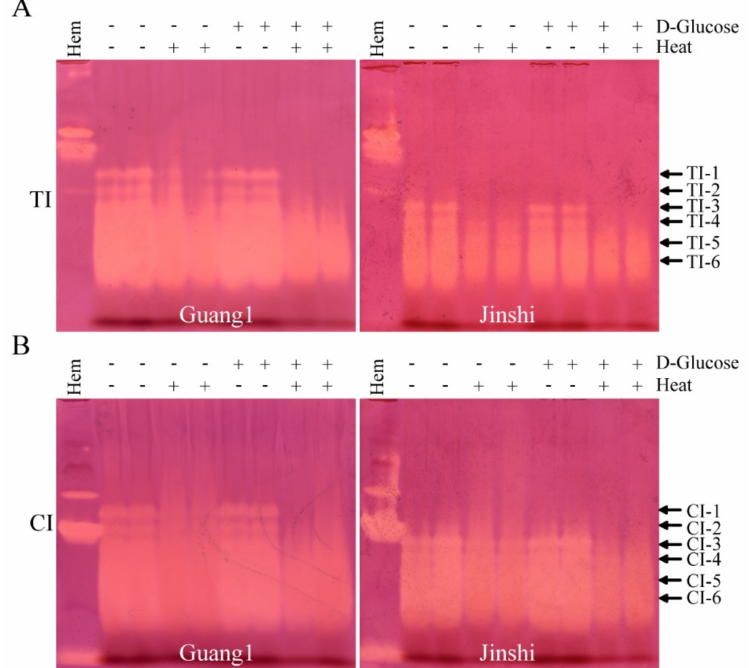
Figure 6. Maillard reaction could weaken the activities of TIs and CIs from leaves of Guang1 and Jinshi. Activity staining of TIs ( A ) and CIs ( B ) from leaves of mulberry varieties Guang1 and Jinshi based on alkaline Native PAGE. “TI” and “CI” represent trypsin inhibitor and chymotrypsin inhibitor, respectively. B. mori hemolymph from day-5 fifth-instar larvae represented by “Hem” was used as positive control. “+” or “-” indicates with or without D-Glucose and heat treatment. The arrows show activity-stained bands of trypsin inhibitors and chymotrypsin inhibitors, which are named “TI-1~TI-6” and “CI-1~CI-6” from top to